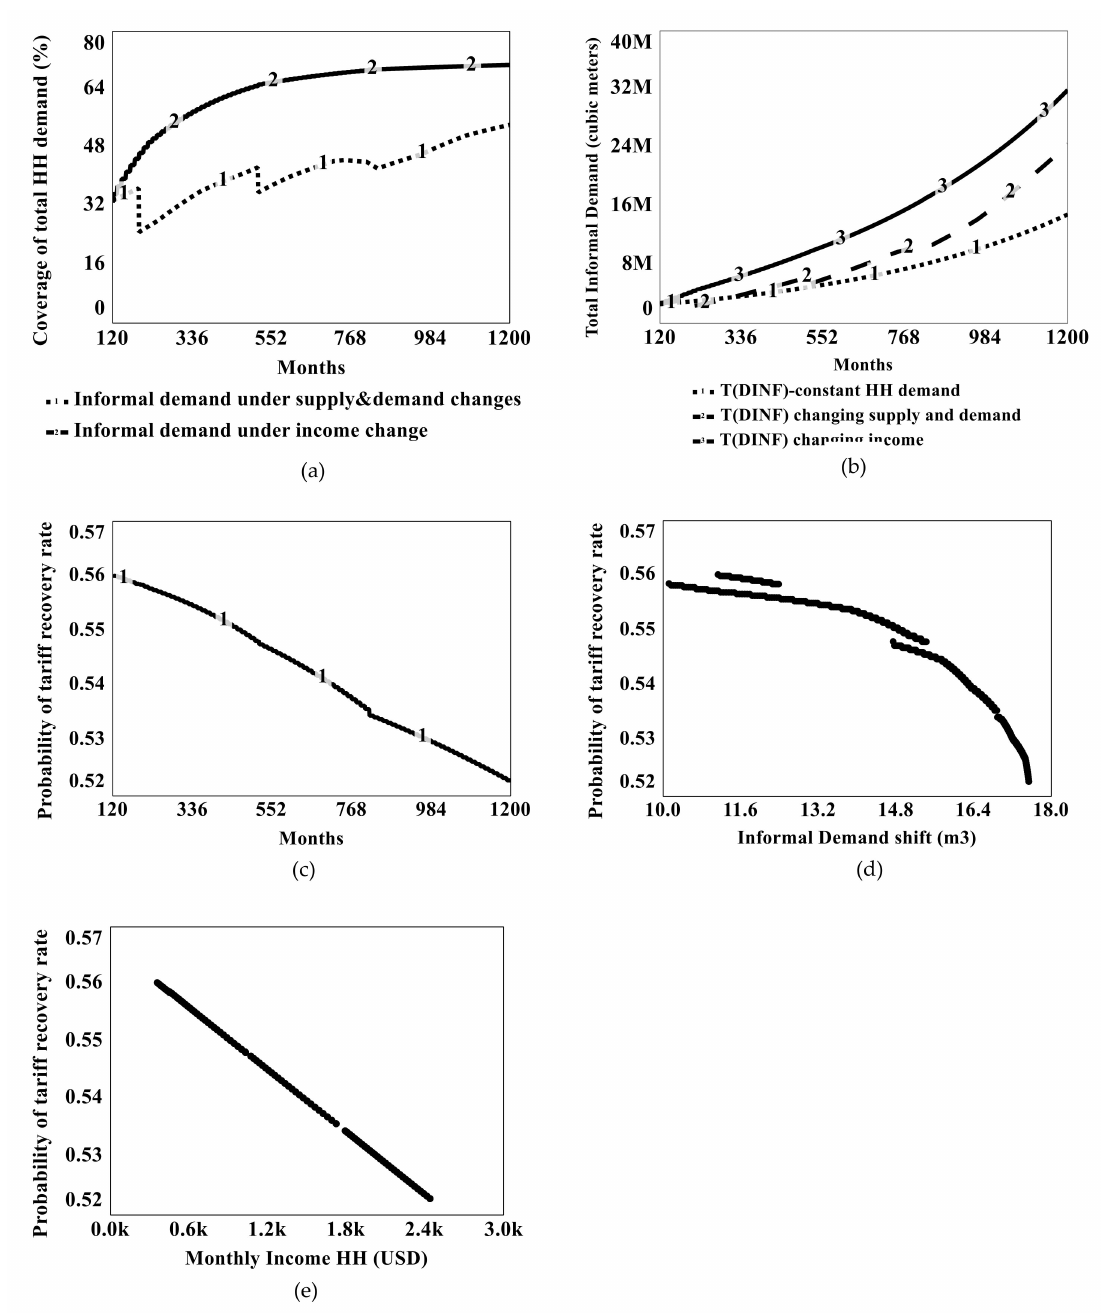
Figure 3. ( a ) Informal water demand at HH level under supply demand gap and income change ( b ) Total informal demand (million cubic meters)at city level under current infrastructure capacity, population increase and income change ( c ) Probability of HH’s tari ff recovery rate over simulation period; ( d ) probability of tari ff recovery against informal demand; ( e ) against income